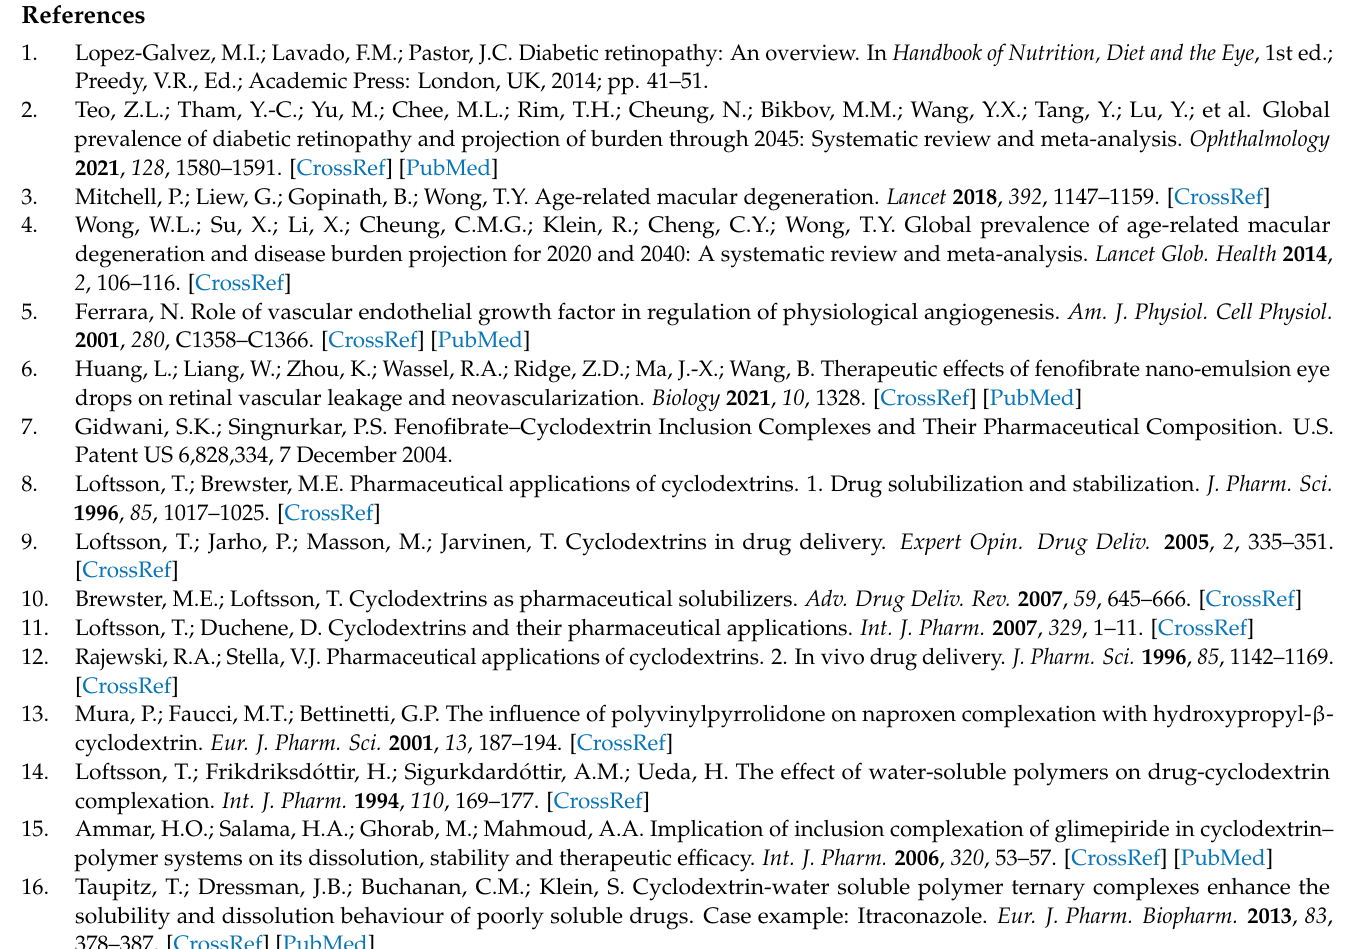
Table S1: Kinetic release rate constants (K), correlation coefficient (R 2 ) and diffusion exponent ( n ) of various models ( n =